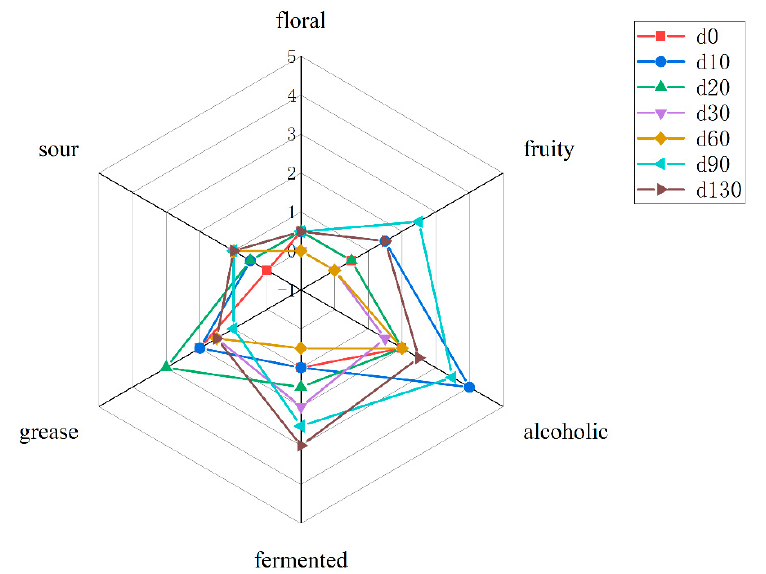
Figure 1. The radar plot of flavor characteristics during sufu fermentation. A score of 0 represents non-existent, 1 represents very slight, 2 represents slight, 3 represents obvious, 4 represents significant, and 5 represents highly significant.